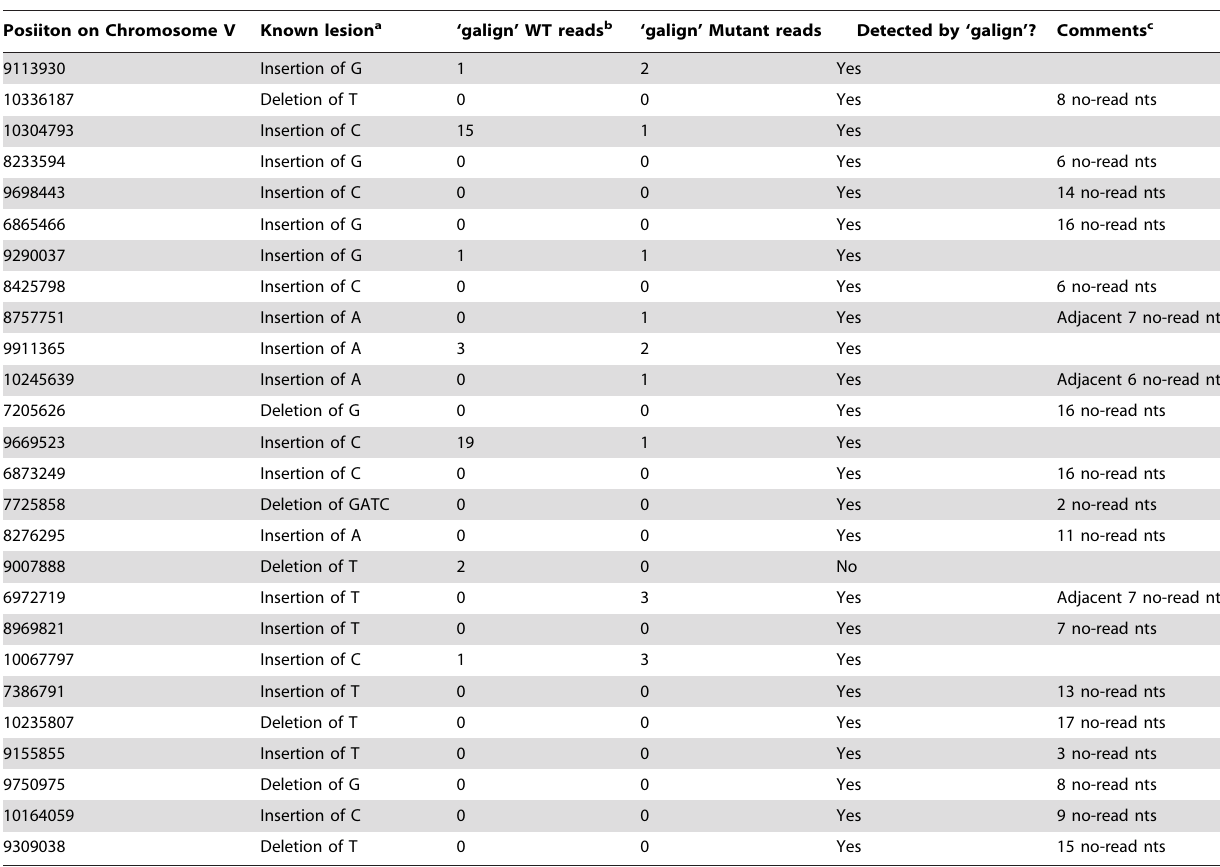
Table 2. Prediction of deletions and insertions by ‘galign’.